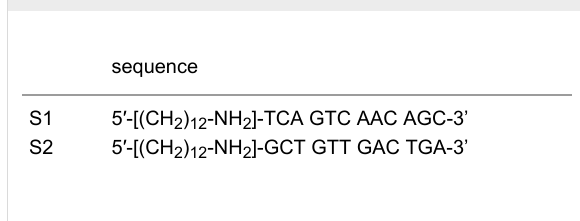
Table 1: Sequences of ssDNA used for conjugation with TPA and subsequent self-assembly.